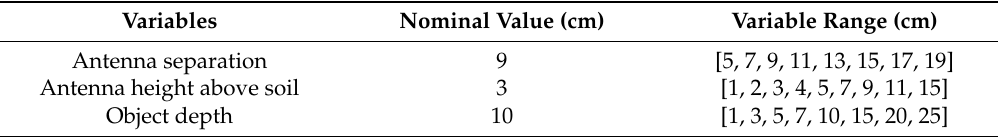
Table 4. Variables for geometrical configuration